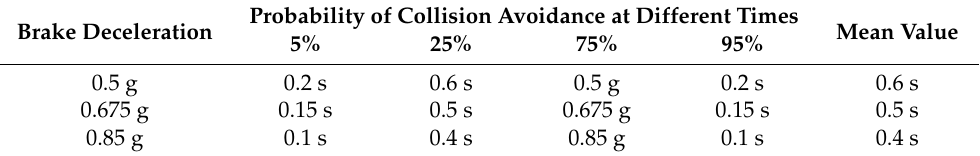
Table 2. Collision avoidance probability under dual variables of braking strength and TTC thresh- old.